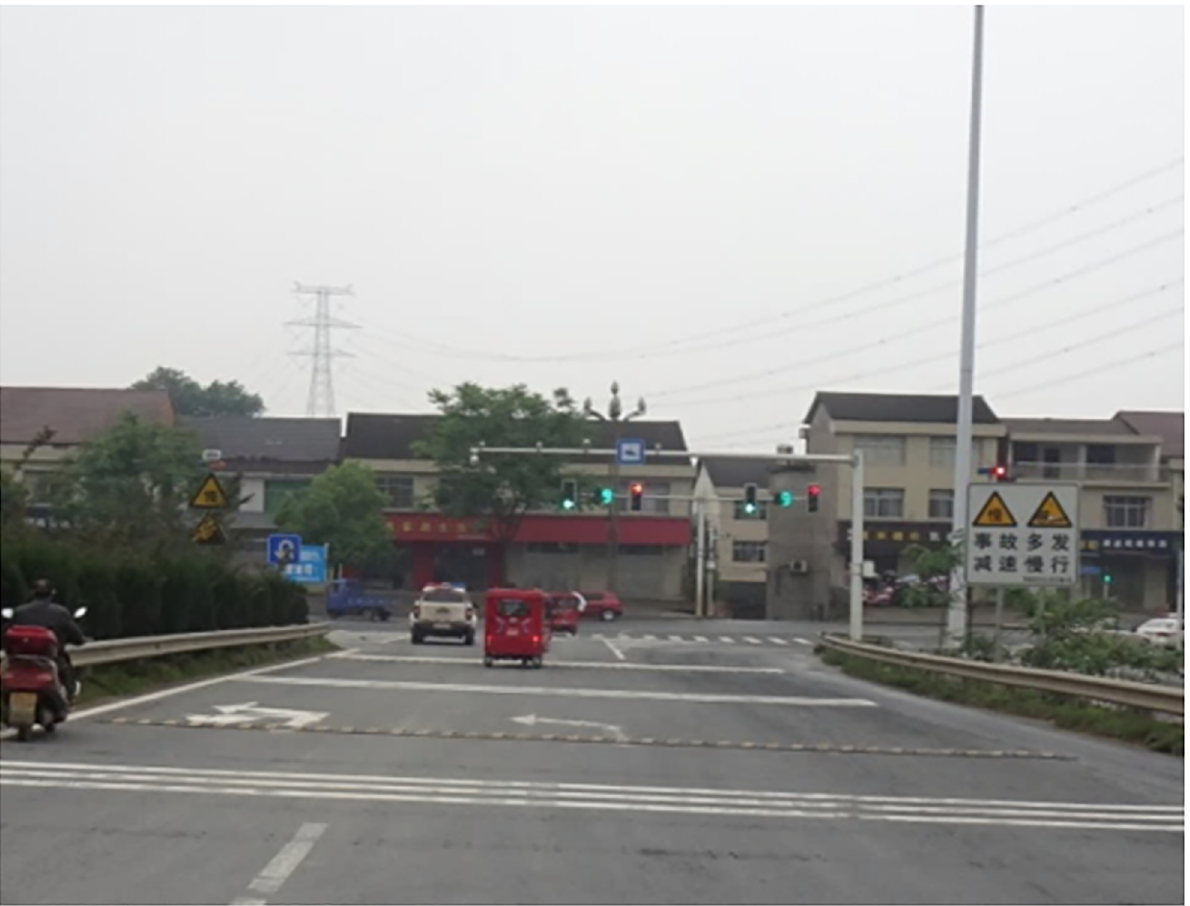
Fig 2. A long downhill T-junction in Changde,